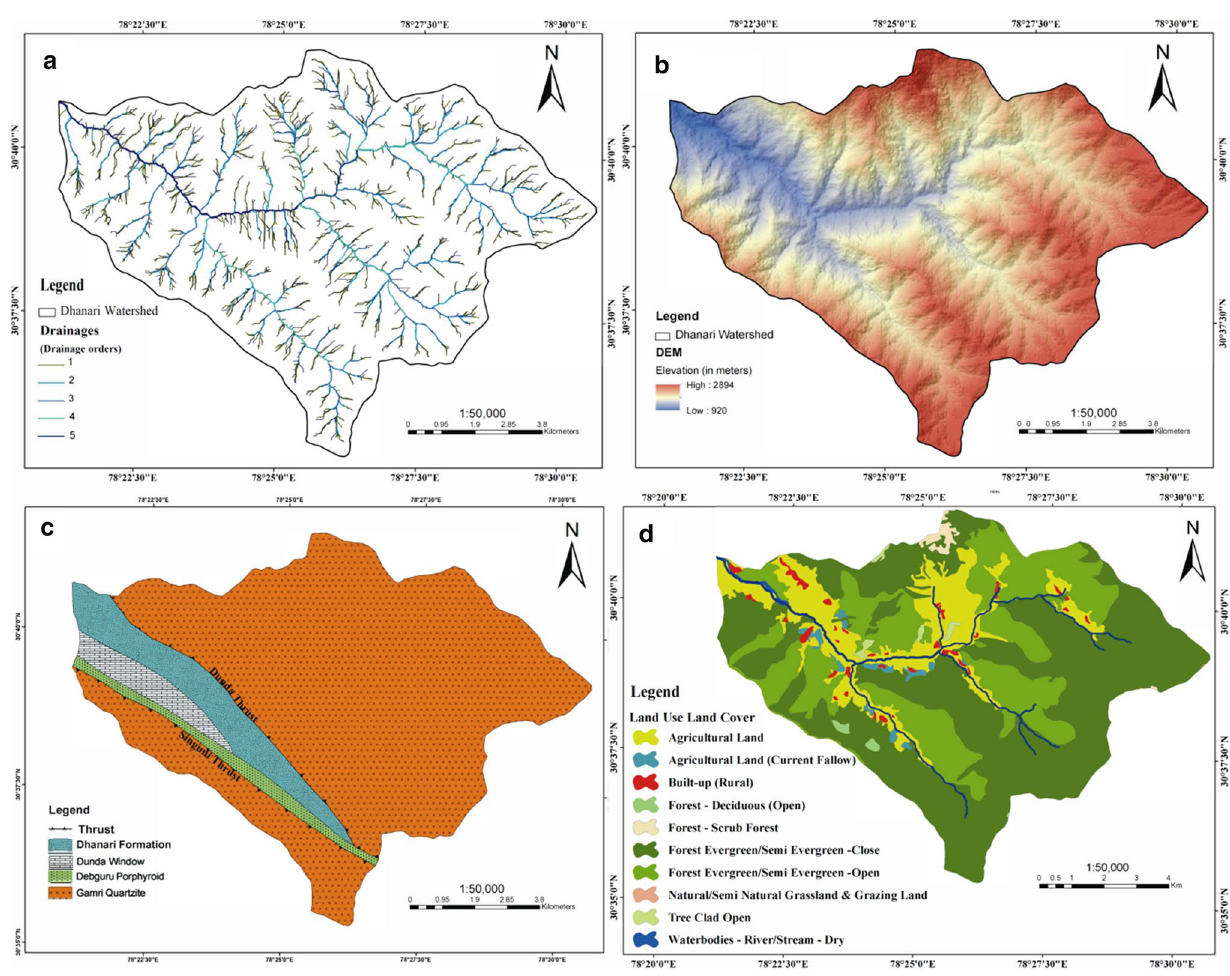
Fig. 2 Thematic layers showing a drainage map, b digital elevation model, c geological setup (after Jain 1971; Fuchs and Sinha 1978; Valdiya 1980) and d land use and land cover pattern of the Dhanari